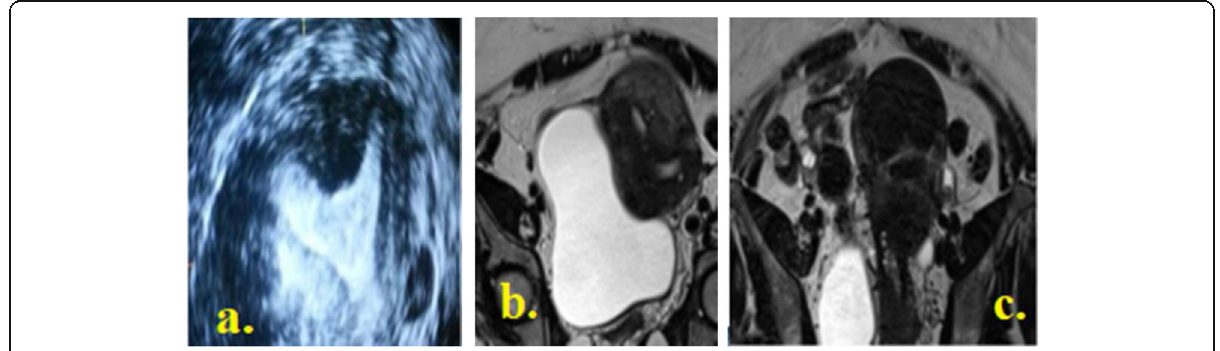
Fig. 7 A 40-year-old married female patient complaining of recurrent abortions. a Partial septate (class U2A) by 3DTVS showing fundal indentation > 50% of uterine wall thickness. b MRI coronal T2 showing areas of low signal causing fundal indentation. c Multiple focal myometrial lesions, fibroids. Class U0 according to MRI